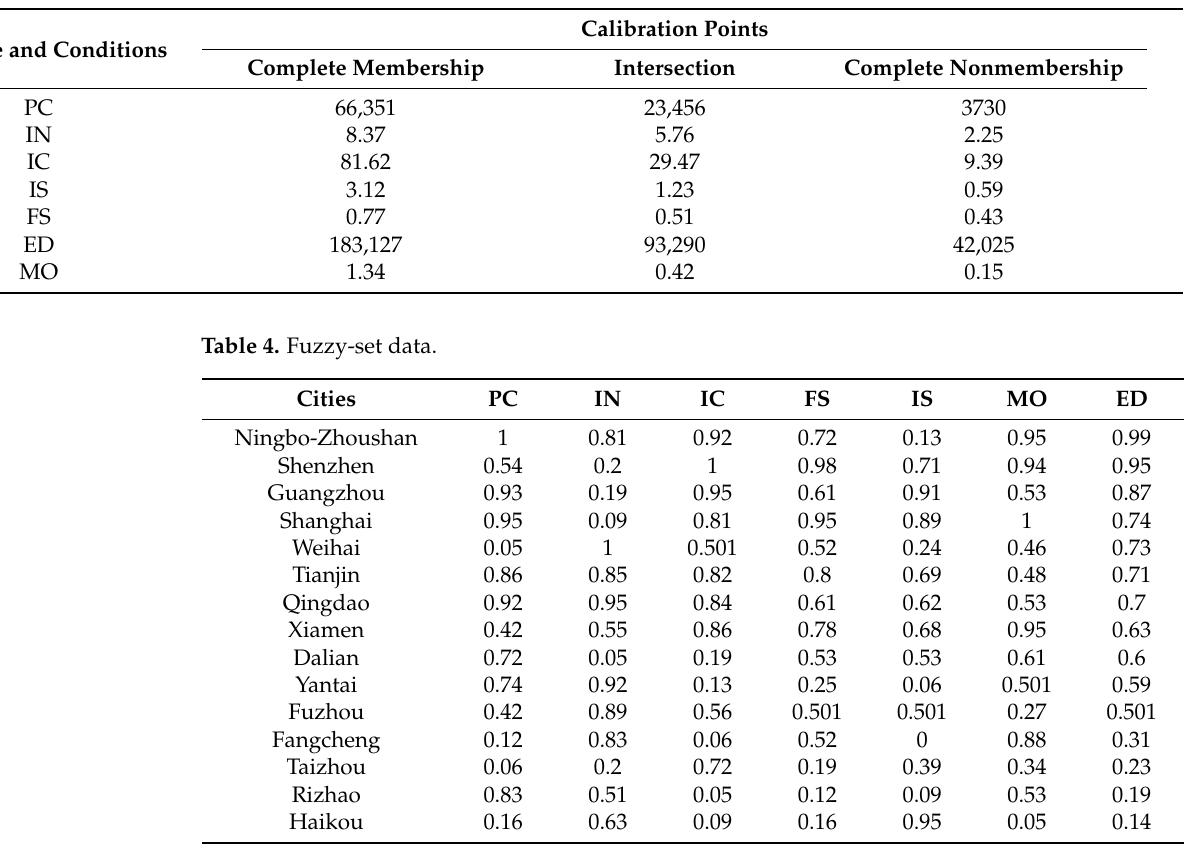
Table 3. Calibration.